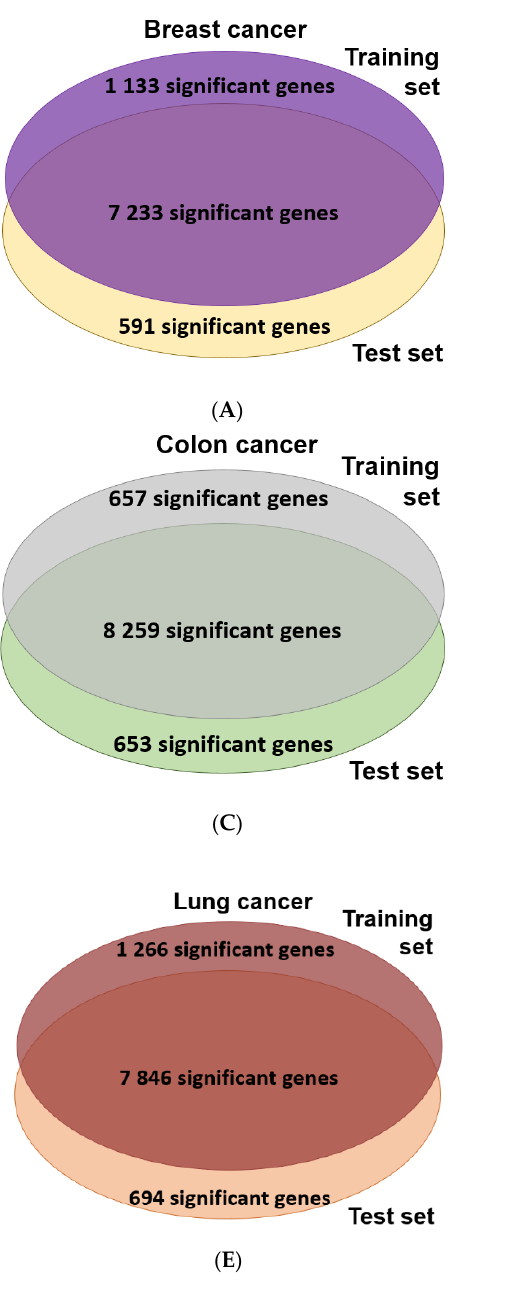
Figure 4. Volcano plots and Venn diagrams of differentially expressed genes in breast, colon and lung cancer using equally sized training–test sets —Venn diagram ( A ) and Volcano plot ( B ) from breast cancer; Venn diagram ( C ) and Volcano plot ( D ) from colon cancer Venn diagram (E) and Volcano plot (F) from lung cancer.